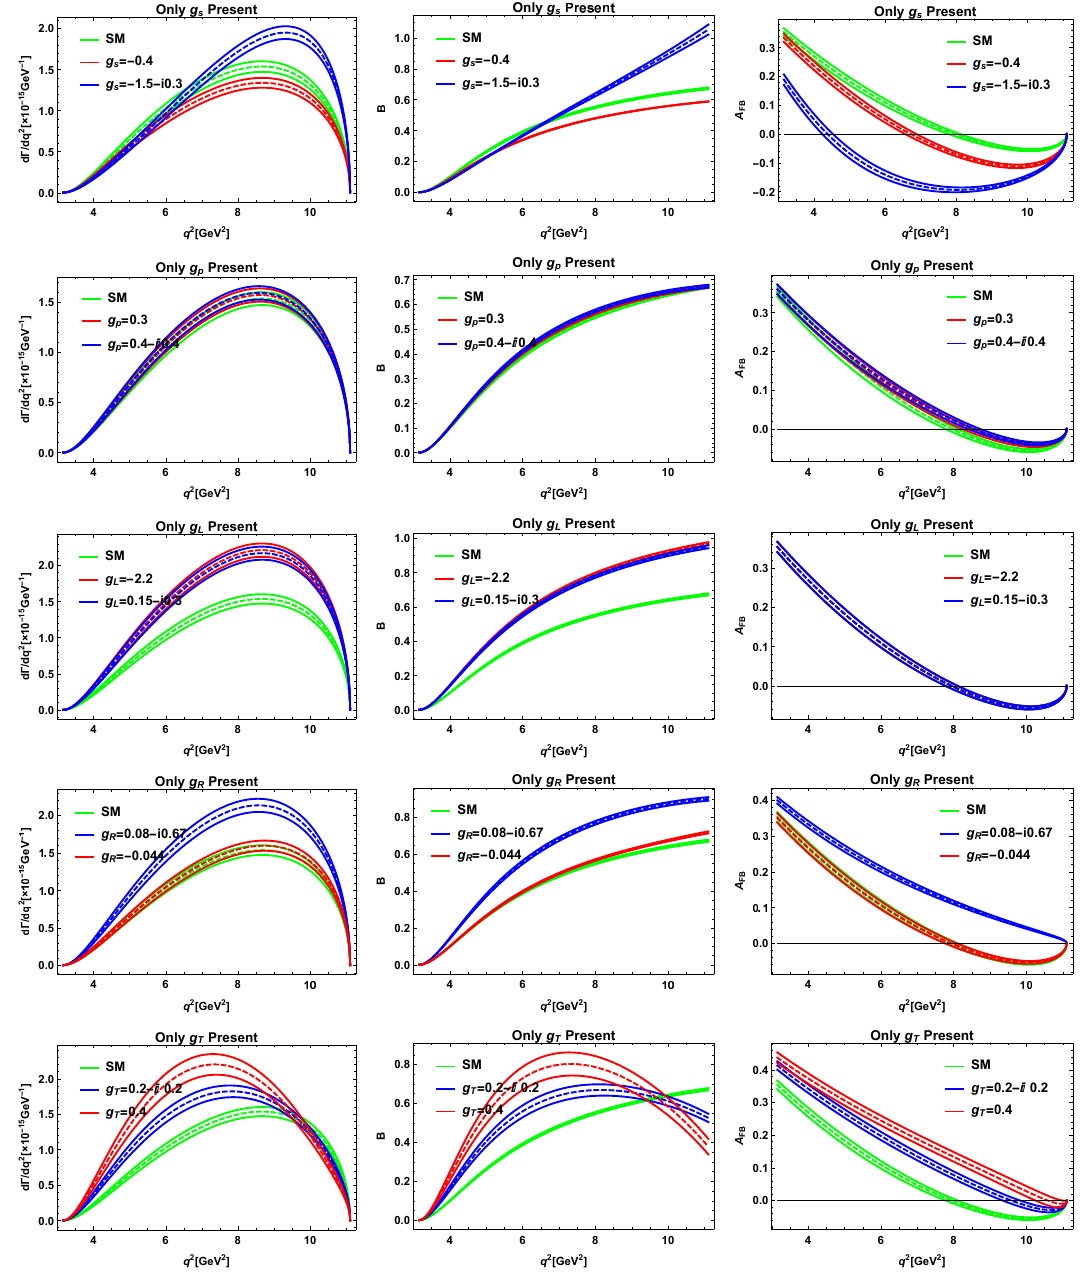
Figure 4 . The effect of individual new-physics couplings on the Λ b Λ c τ ¯ ν τ differential decay → rate (left), the ratio of the Λ b Λ c τ ¯ ν τ and Λ b Λ c ℓ ¯ ν ℓ differential decay rates (middle), and the → → Λ b Λ c τ ¯ ν τ forward-backward asymmetry (right). Each plot shows the observable in the Standard → Model and for two representative values of the new-physics coupling (one real-valued choice and one complex-valued choice). The bands indicate the 1 σ uncertainties originating from the Λ b Λ c → form